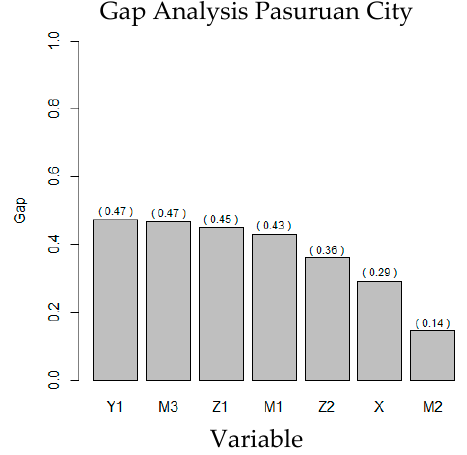
Figure A4. Bar Diagram of Gap Analysis of Pasuruan City.